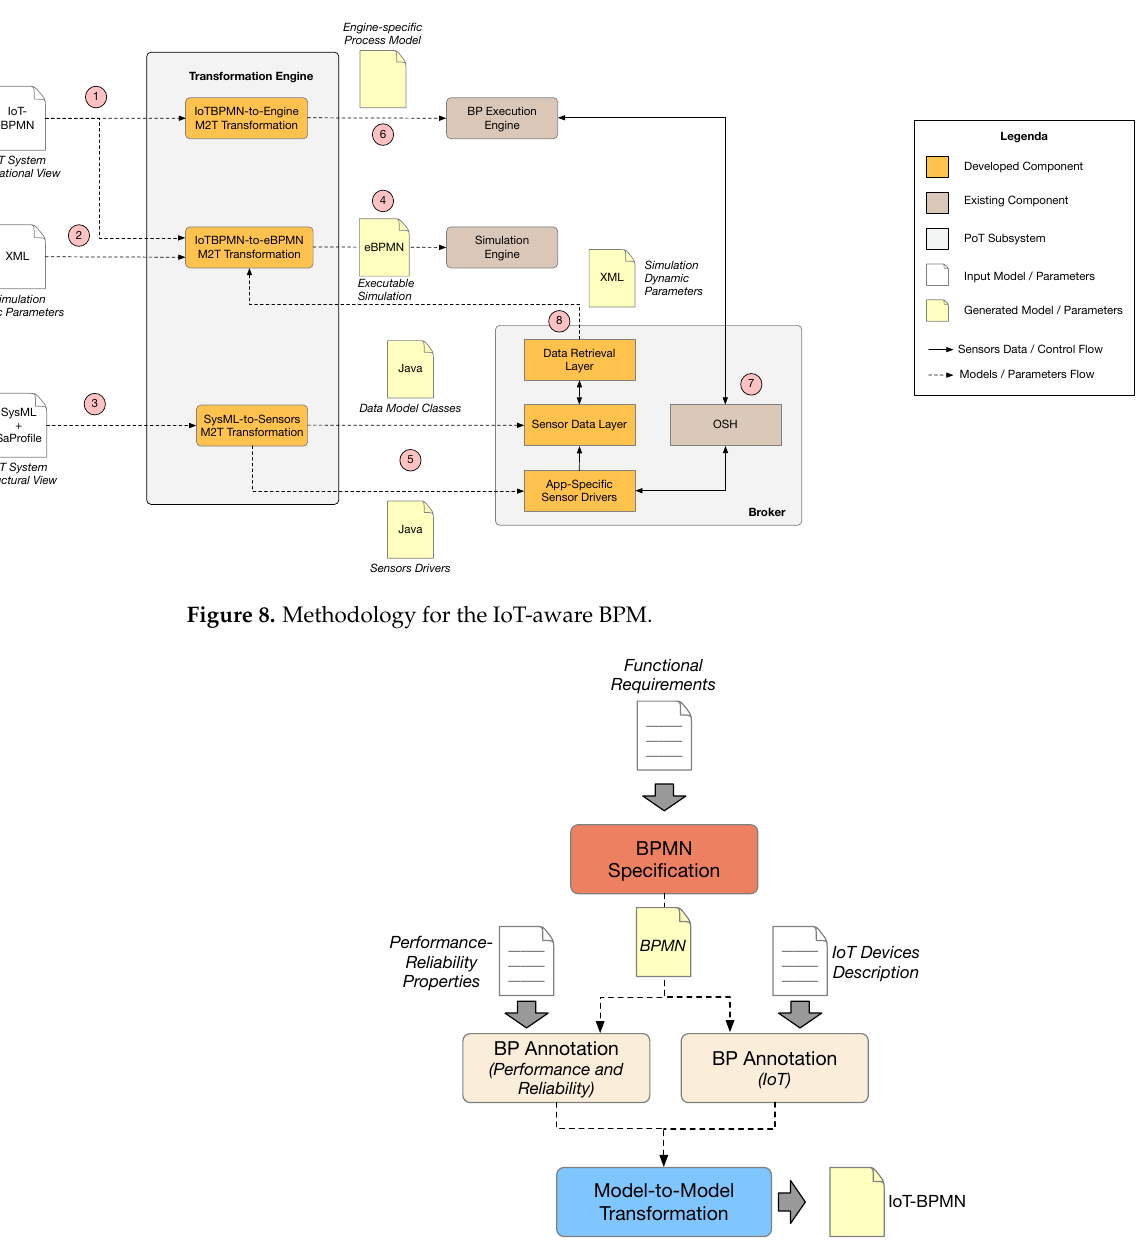
Figure 9. Specification of PyBPMN and